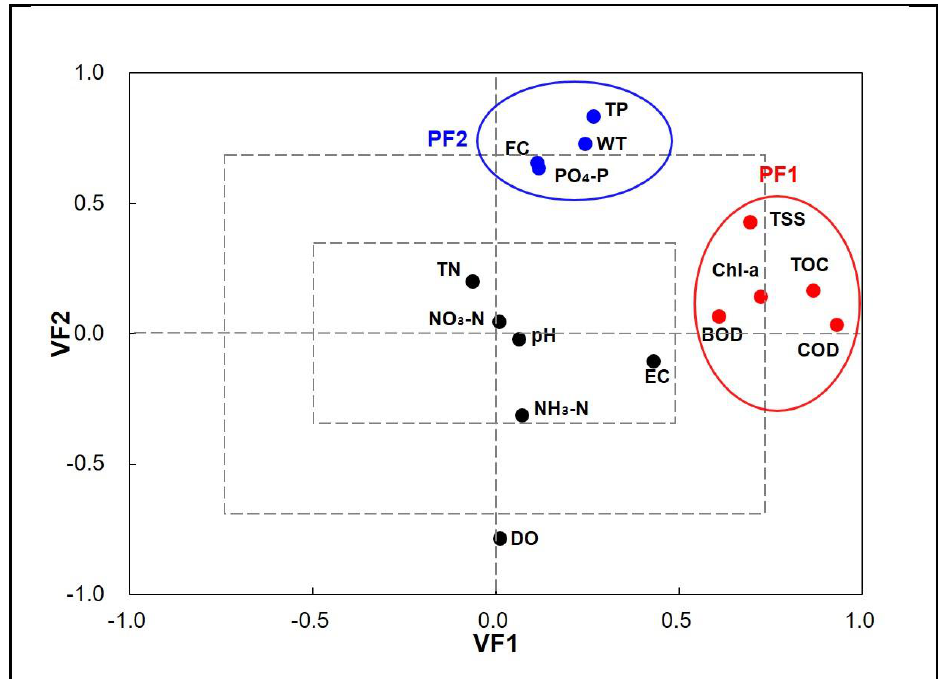
Figure 3. Major factors through the scatter plot of VF1 and VF2. Red indicates the principal factor1 and blue indicates the principal factor2. VF, varifactor; PF, principal factor; WT, water temperature; DO, dissolved oxygen; BOD, biochemical oxygen demand; COD, chemical oxygen demand; TOC,